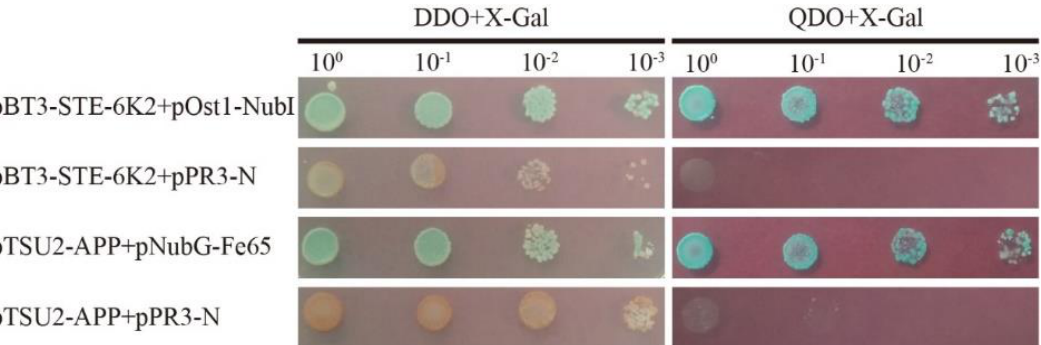
Figure 2. Evaluation of the pBT3-STE-6K2 bait vector. Plasmid combinations of pBT3-STE-6K2 and pOst1-NubI, pBT3-STE-6K2, and pPR3-N were co-transformed into yeast NMY51 cells in a 10× dilution series of 10- μL aliquots , which were then cultured on DDO+5-bromo-4-chloro-3- indolyl β -D-galactoside (X-Gal) or QDO+X-Gal agar plates to evaluate the toxicity or auto-activation of 6K2, respectively. Yeast cells co-transformed with pTSU2-APP and pNubG-Fe65 were used as positive controls, pTSU2-APP and pPR3-N were used as negative controls. DDO+X-Gal: SD/-Trp/-Leu, supplemented with X-Gal,; QDO+X-Gal: SD/-Trp/-Leu/-His/-Ade, supplemented with X-Gal.